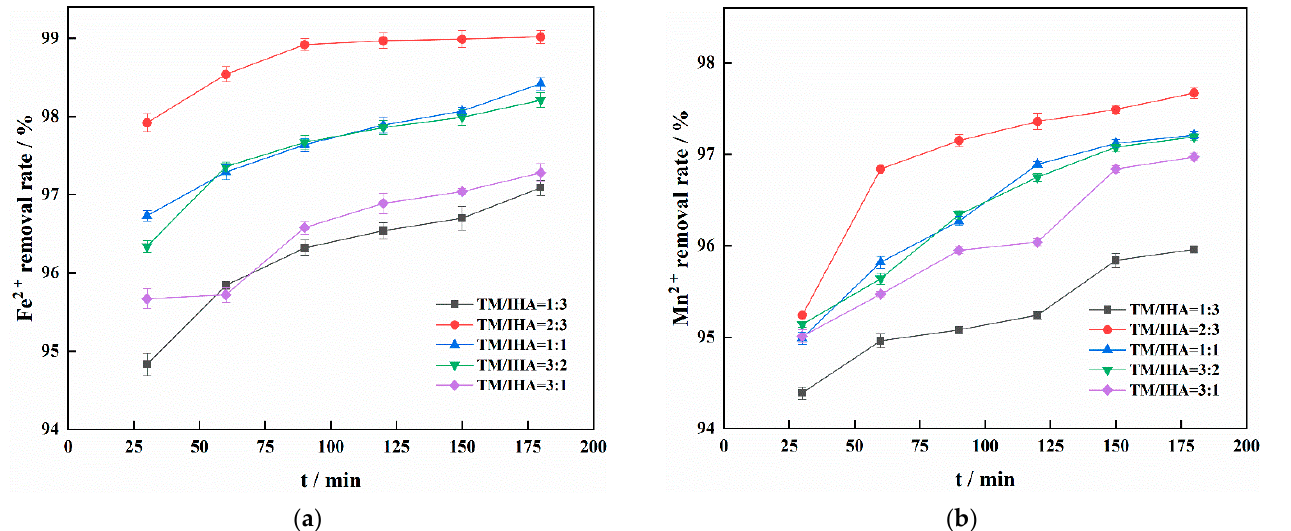
Figure 1. Effect of different mixing ratios on the removal of Fe 2+ ( a ) and Mn 2+ ( b ).